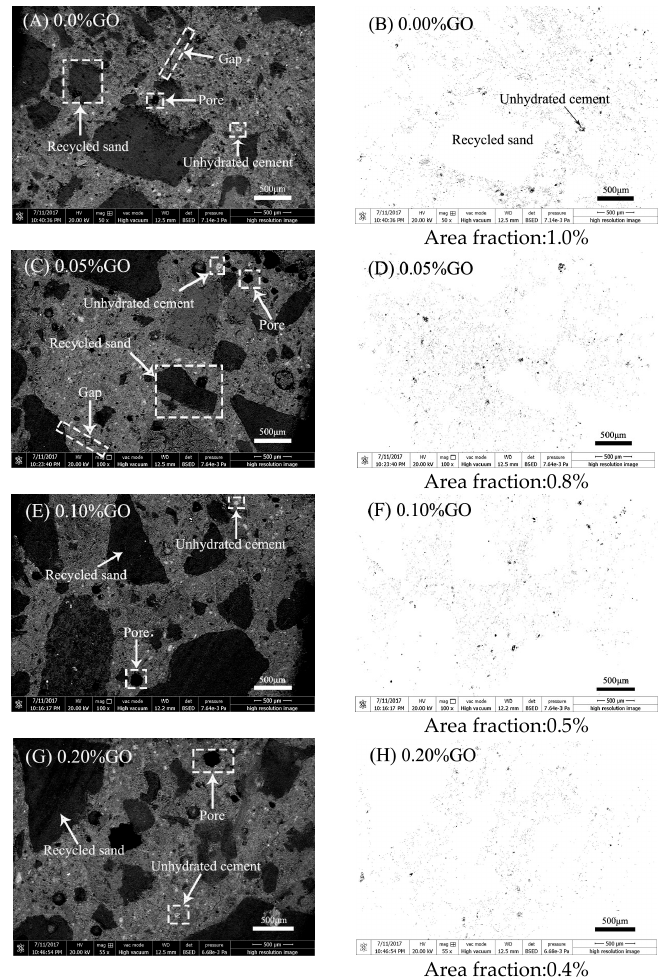
Figure 13. SEM and backscattered mode (BSEM) images of the area fraction of unhydrated cement at 28 days: ( A , B ) 0.0% GO; ( C , D ) 0.05% GO; ( E , F ) 0.10% GO; ( G , H ) 0.20% GO. Area of unhydrated cement particles (black area) Area fraction = Total area of RFA mortar cross-section